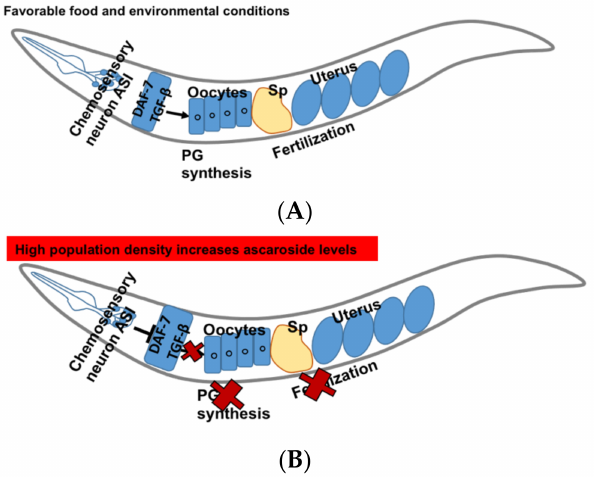
Figure 4. DAF-7/TGF- β signaling pathway in C. elegans . ( A ) Function of DAF-7/TGF- β in favorable condition. ( B ) DAF-7/TGF- β signaling in response to high population density results in increase in ascarosides levels, which in turn inhibits PG synthesis and fertilization events in C. elegans . The expression of DAF-7 is down-regulated by increased levels of ascarosides which inhibit the PG synthesis in the oocytes and cause sperm guidance defects (Figure